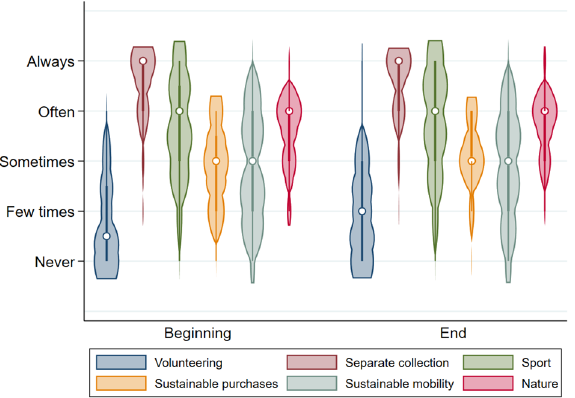
Figure 2. Distribution of responses related to sustainability behaviours, divided between the beginning and the end of term. White dots represent median values. Values at the beginning of term were (mean values in parentheses): 1.5 (1.8) for volunteering, 5 (4.3) for recycling, 4 (3.7) for playing sports, 3 (2.9) for using sustainable products, 3 (2.8) for taking public transportation, and 4 (3.5) for engaging with nature. Values at the end of term were (mean values in parentheses): 2 (1.9) for volunteering, 5 (4.5) for recycling, 4 (3.8) for playing sports, 3 (3.1) for using sustainable products, 3 (2.9) for taking public transportation, and 4 (3.7) for engaging with